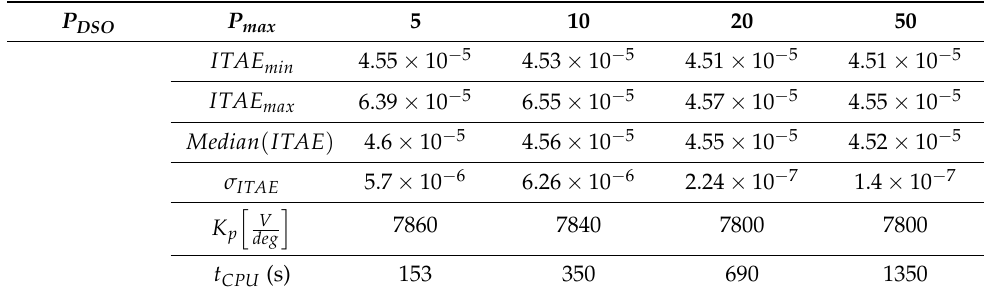
Table 3. P D SO convergence